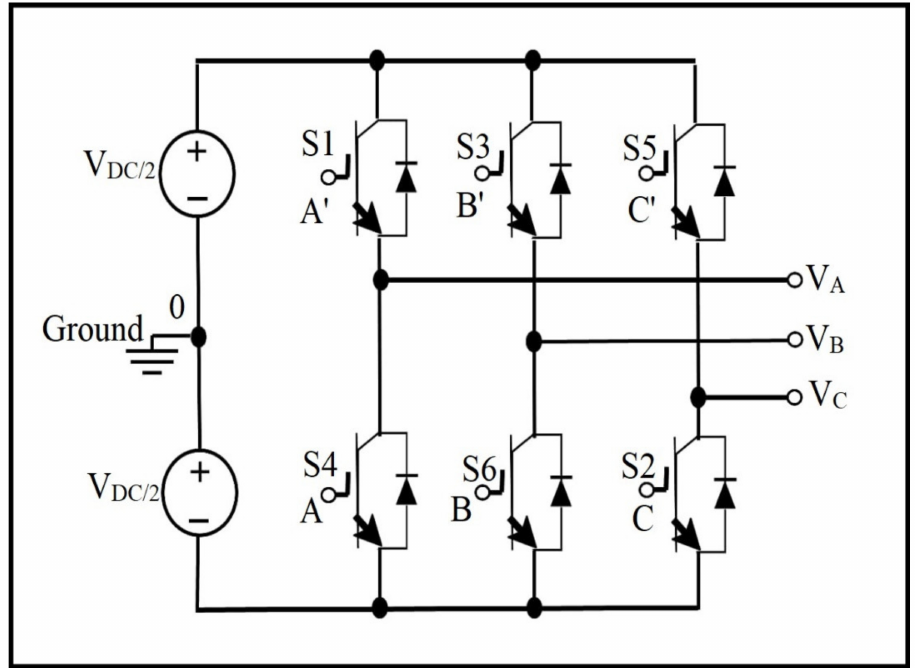
Figure 7. Circuit diagram of an ideal two-level